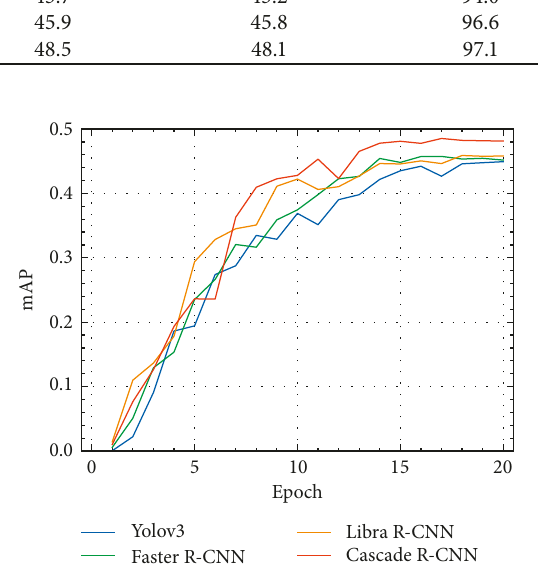
Figure 6: Visualization of the one-stage and two-stage algorithm comparison curve in mAPbest.